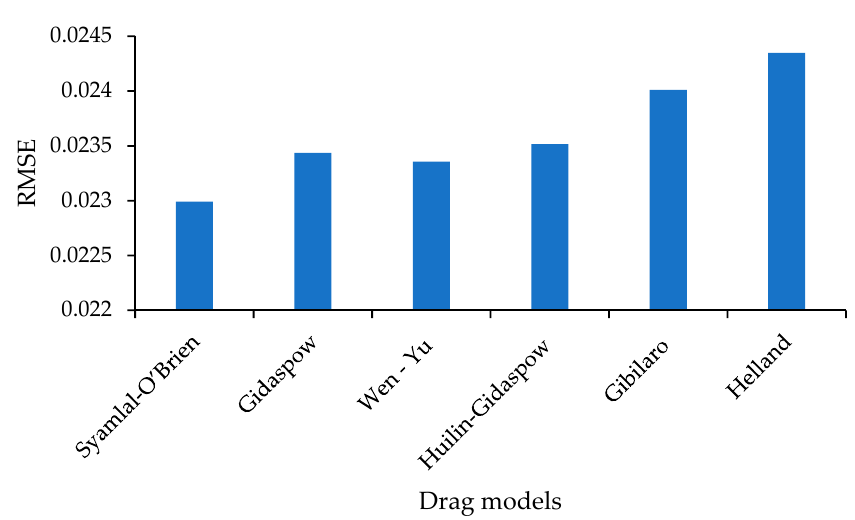
Figure 7. Root mean square error (RMSE) for six different drag model.